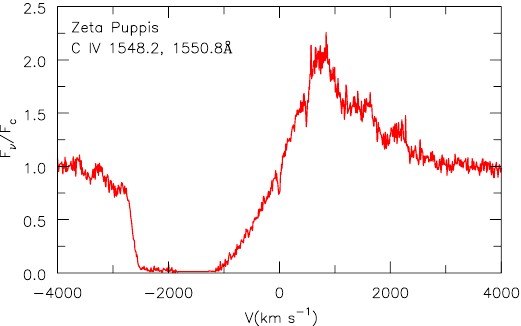
Figure 3. The C IV λλ 1548.2, 1550.8 P Cygni profile in the O4 I(n)fp star Zeta Puppis. The x-axis was computed using v = c ( λ / λ o − 1.0 ) where λ o = 1548.187. The spectrum has been